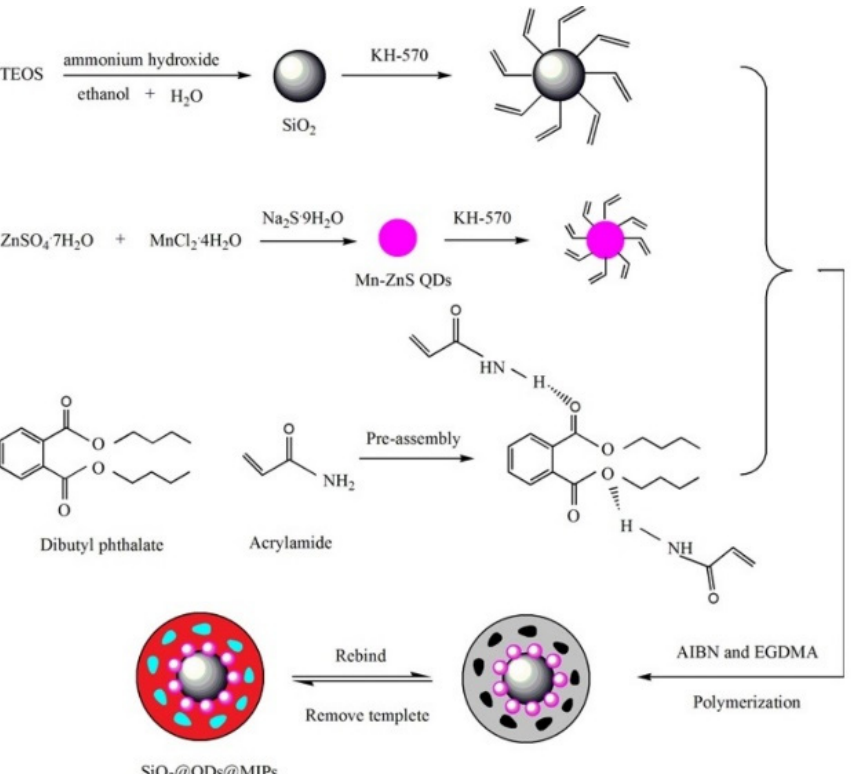
Figure 2. Schematic preparation of a fluorescent hybrid inorganic-organic MIP-QD sensor for the determination of dibutyl phthalate (DBP). Reproduced with permission from [17]. Copyright 2017 Elsevier.